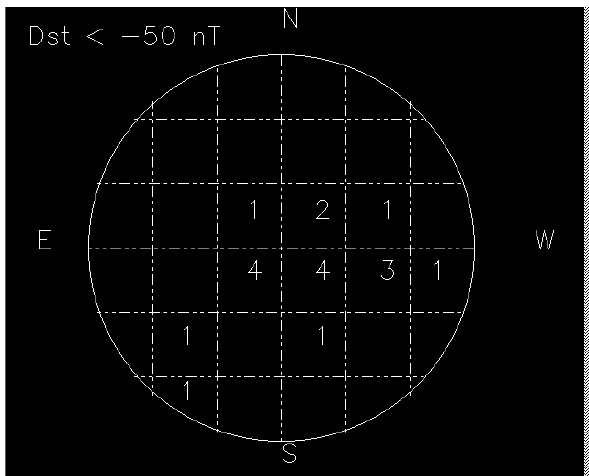
Fig. 12. Positions on the disk of the solar sources of the CMEs chosen in Table 1 (column 7) associated with geomagnetic activity ( D st < − 50nT). Lines are drawn every 30 ◦ and numbers of cases in each box are